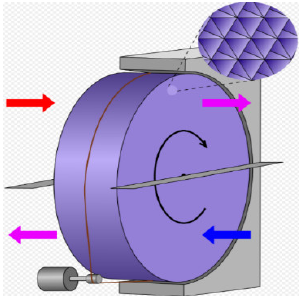
Figure 11. Rotary wheel heat recovery (data processed from Wikipedia [36]).